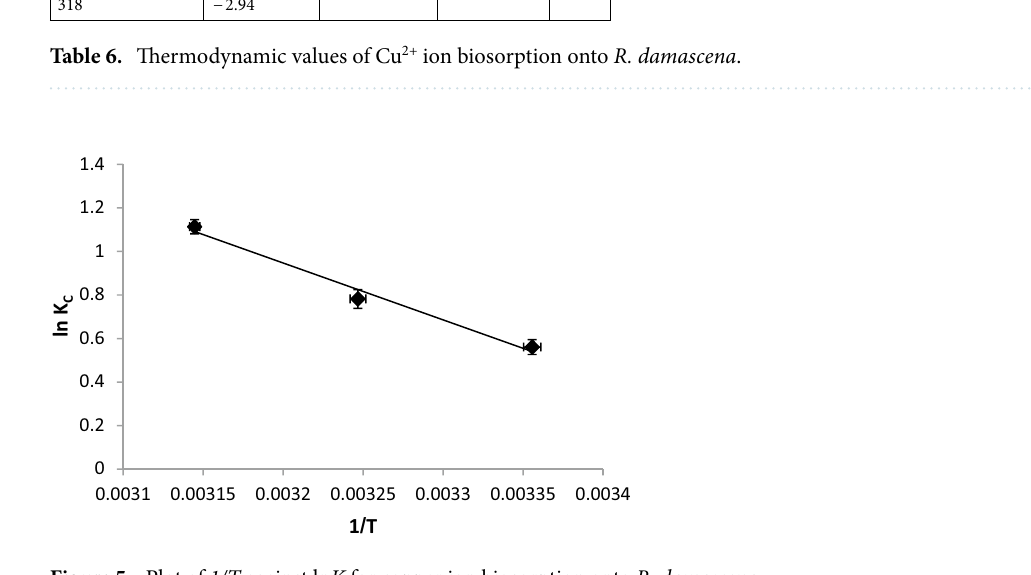
Figure 5. Plot of 1/T against ln K for copper ion biosorption onto R. damascena